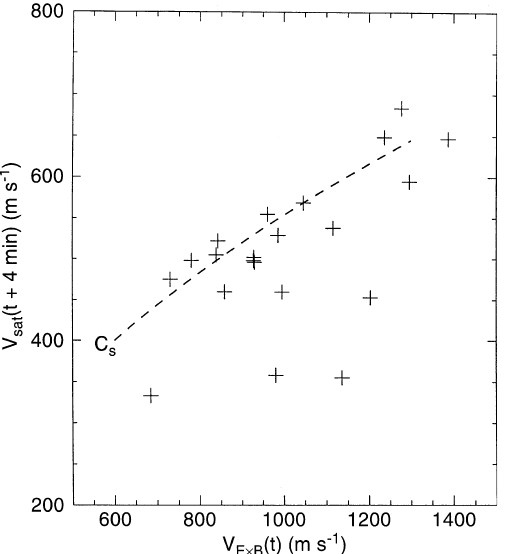
Fig. 8. A comparison of V sat and the estimated value of V E (cid:2) B for the interval 1915 to 2030 UT, 24 November 1995. Also indicated is a theoretical relationship between V E (cid:2) B and the ion-acoustic speed, C s ( dashed line